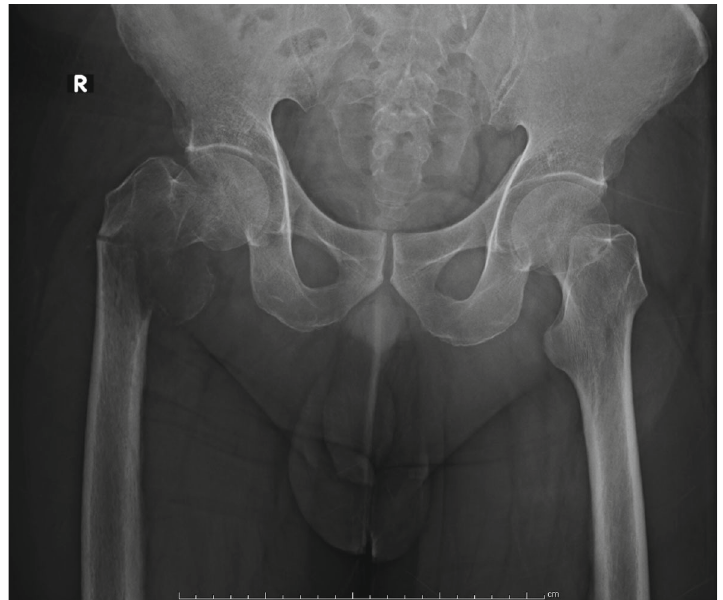
Figure 2: Plain radiograph revealed osteolytic lesion at right proximal femur with minimally displaced pathological fracture at the intertrochanteric